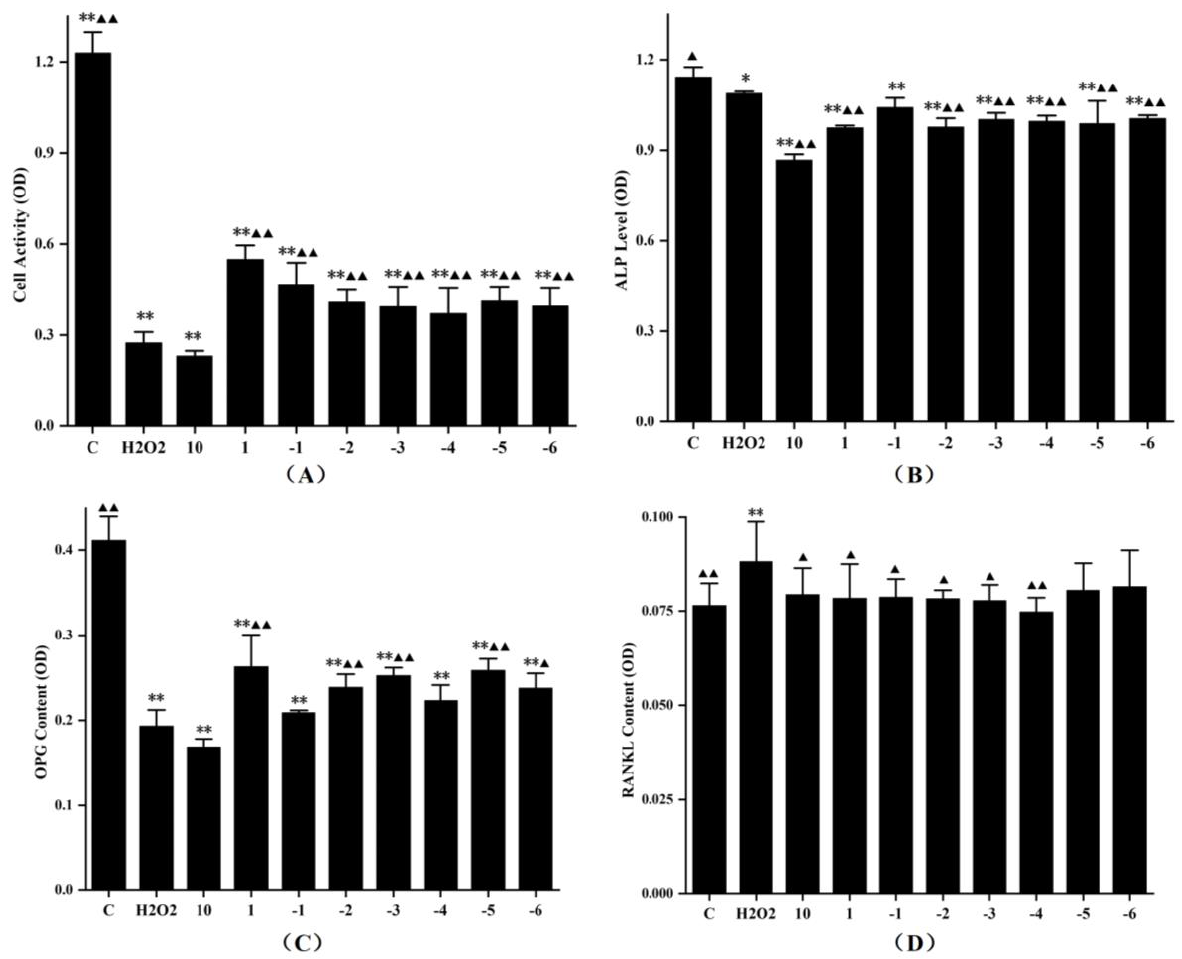
Figure 6. The effects of FLL water extract and 0.45 mM H 2 O 2 on the cell viability ( A ), ALP level ( B ), and OPG protein ( C ) and RANKL protein expression ( D ) of the MC3T3-E1 cells. The cells were treated with various concentrations of FLL for 24 h. Cell viability was determined with the CCK-8 assay, and other results were detected using ELISA kits. The experiment was run twice. Data are presented as the mean ± SD, n = 6 for each group. * p < 0.05 and ** p < 0.01 with control group, ▲ p < 0.05 and ▲▲ p < 0.01 compared with H 2 O 2 group.